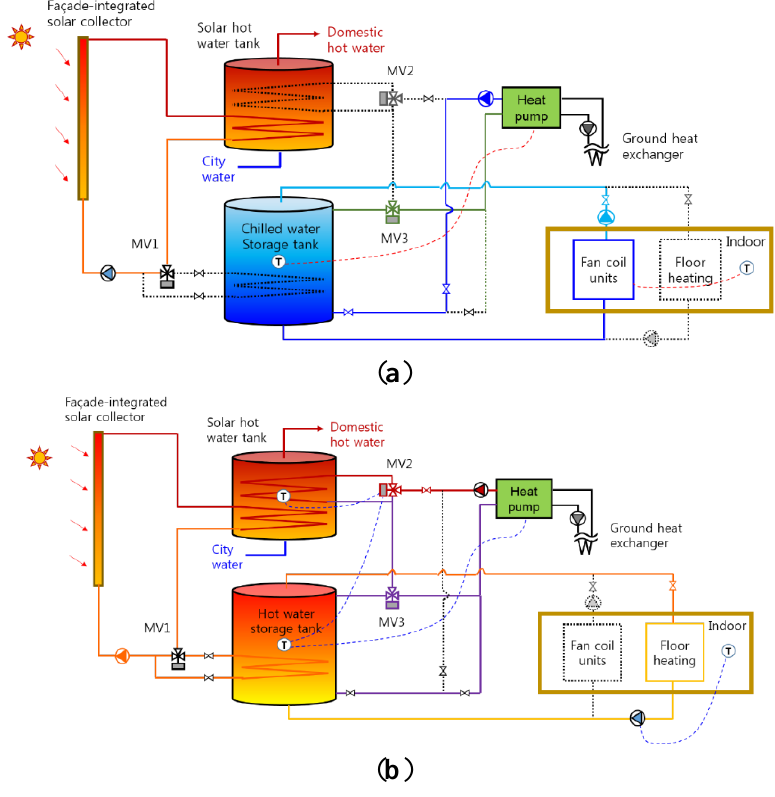
Figure 1. Schematic diagram for ( a ) cooling and ( b ) heating